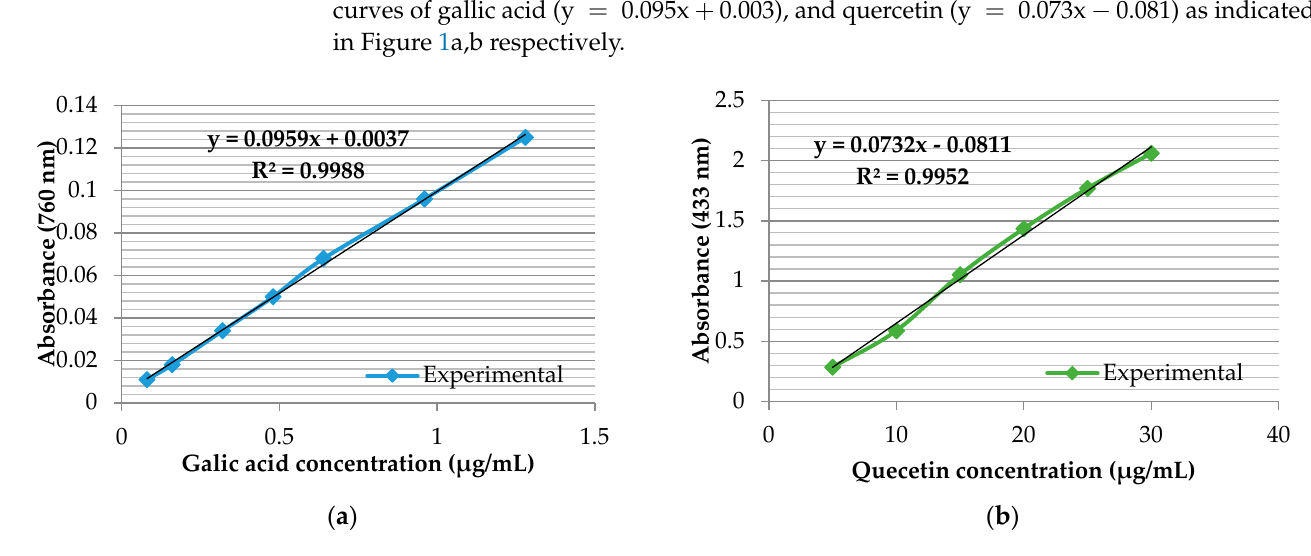
Figure 1. Calibration curves of ( a ) gallic acid and ( b ) quercetin (black represent linear curves).